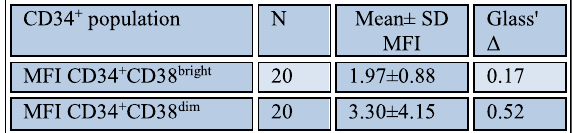
Table 3. The expression level of PTPRG in the sub-population of myeloid progenitor